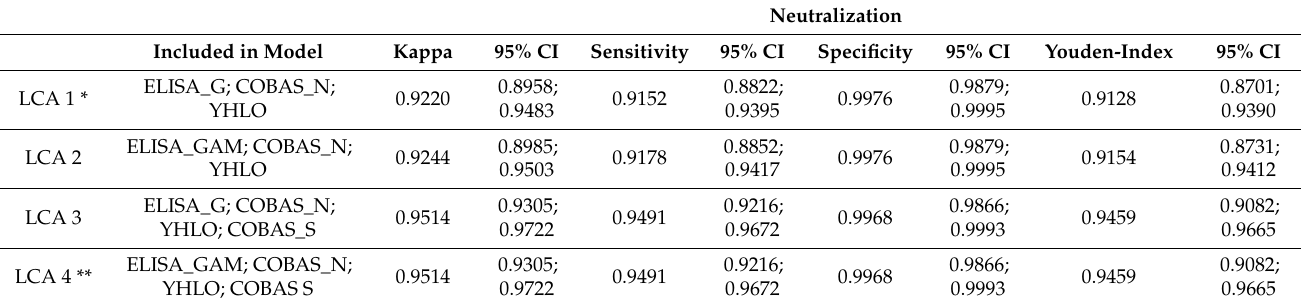
Table 4. Agreement of seropositivity determined through various LCA-models and dichotomized neutralization results within the complete group ( n = 856 weighted to n = 4185). Shown are: Tests included in the model, Cohen’s kappa, sensitivity, specificity and Youden-Index accompanied by